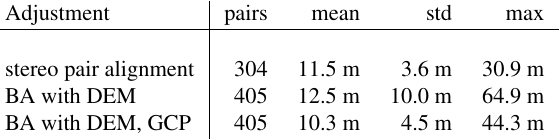
Table 2: Summary of errors against the Euro-Maps 2D. Note that the stereo pair alignment failed for the more demanding scenes with flat